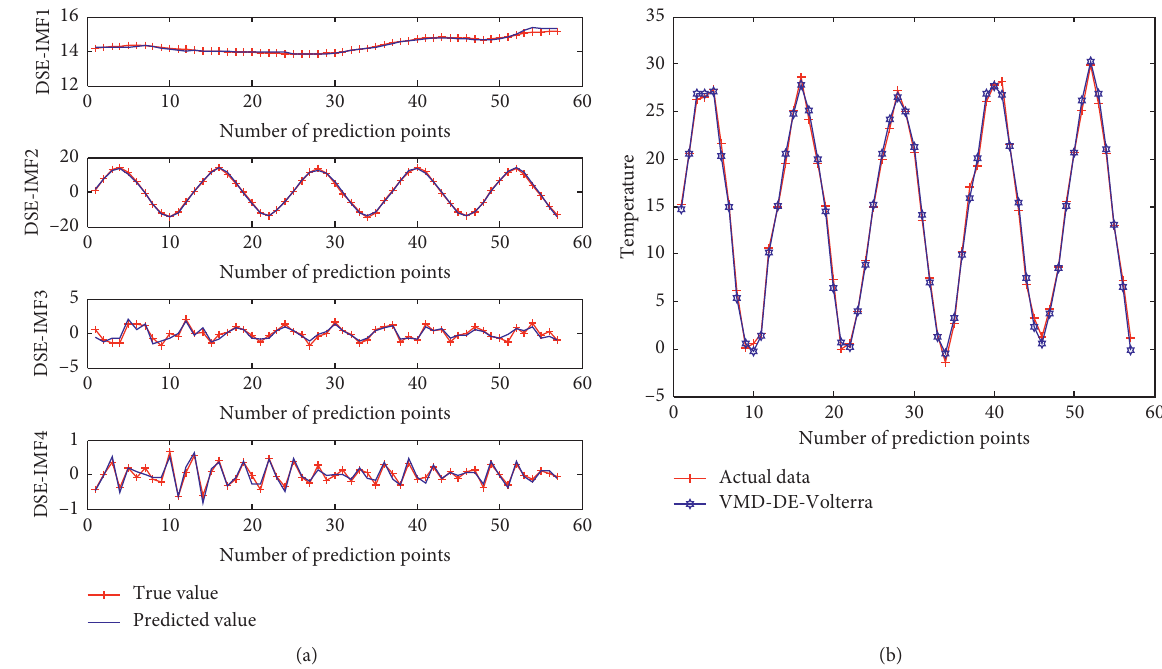
Figure 8: (a) Reconstructing subsequence prediction result; (b) VMD-DSE-Volterra prediction